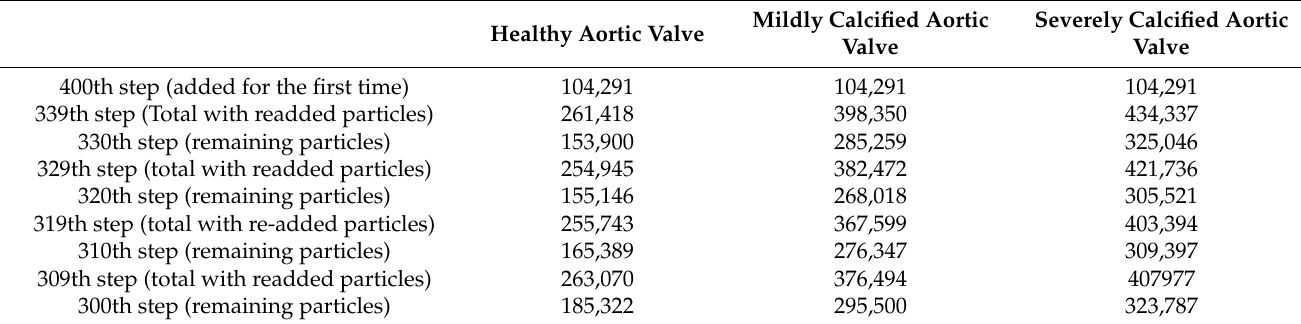
Table 1. The number of particles in the solution domain for the backward FTLE PRT analysis. Mildly Calcified Aortic Severely Calcified Healthy Aortic Valve Valve